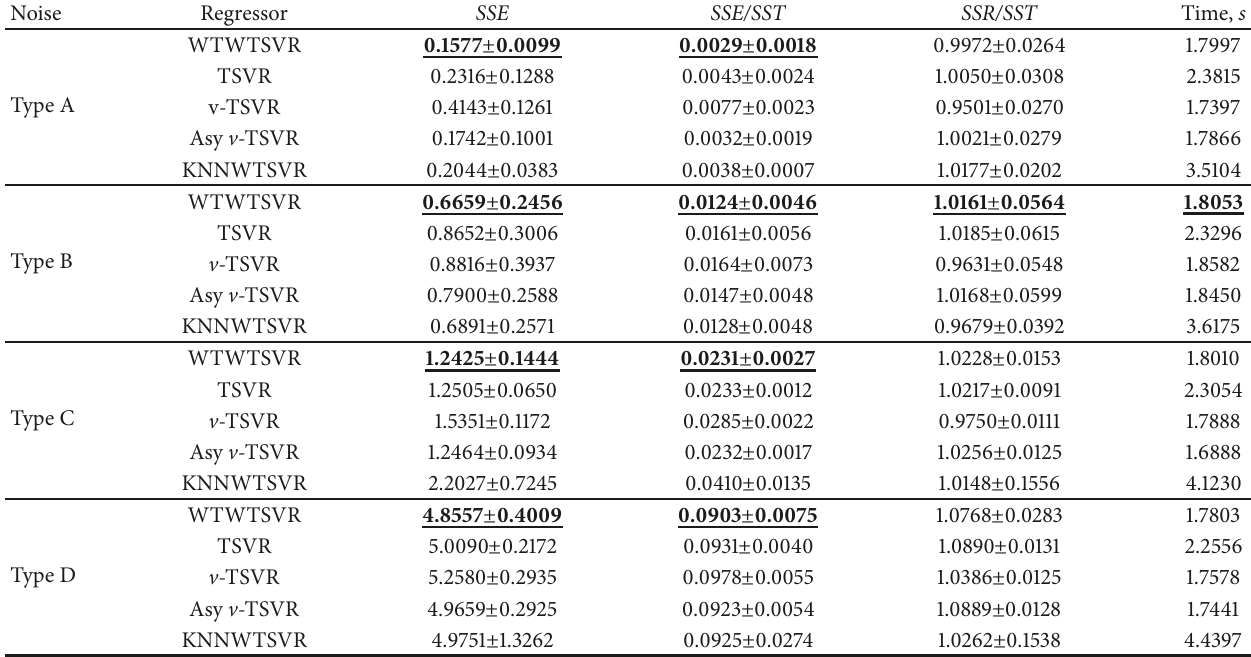
Table 5: Comparisons of four regression methods on Sinc functions with different